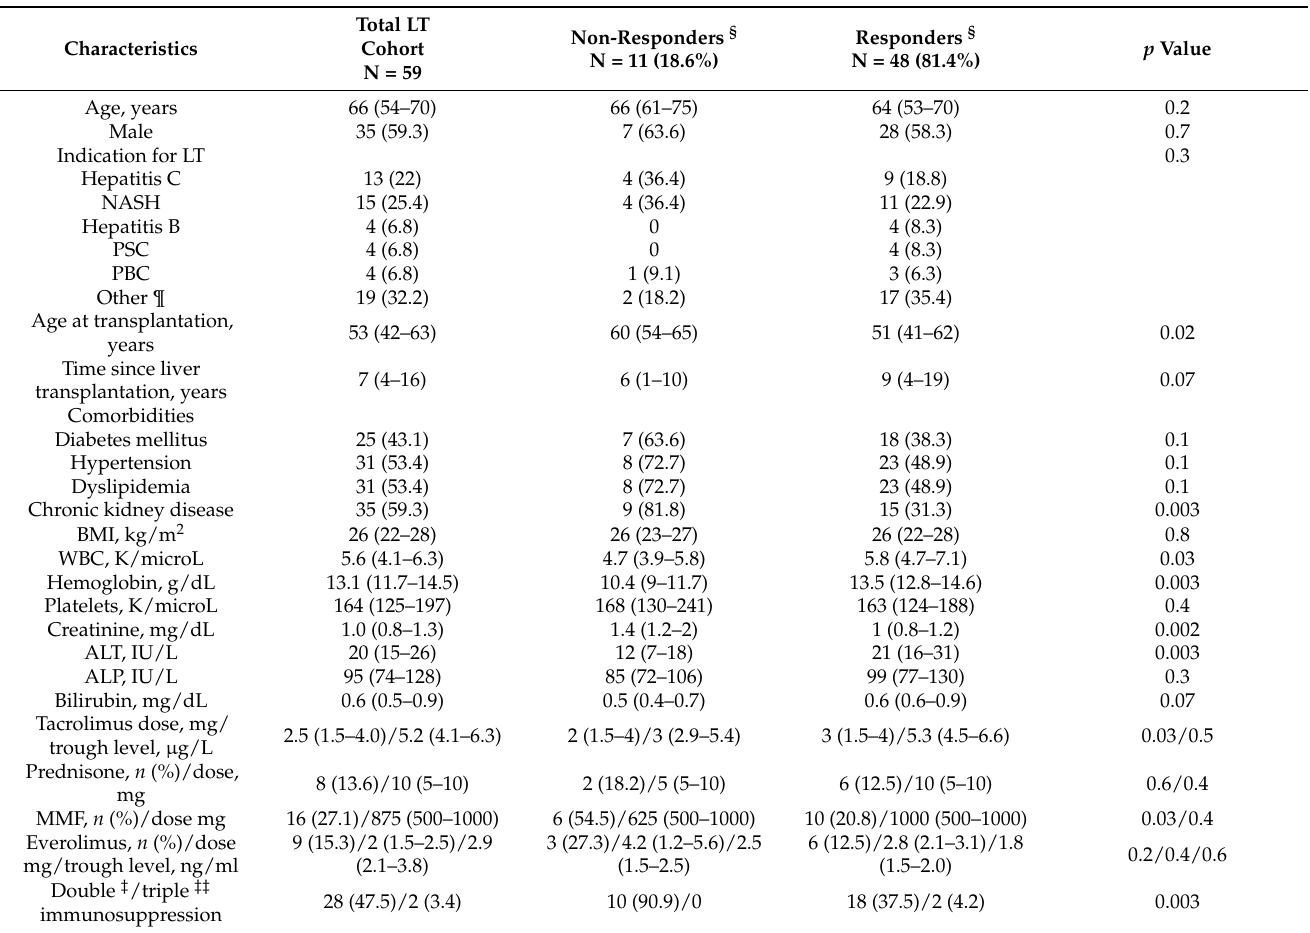
Table 2. Baseline demographics and clinical and laboratory characteristics of liver transplant (LT) patients with versus without immunologic response 22 days after the third BNT162b2 mRNA vaccine